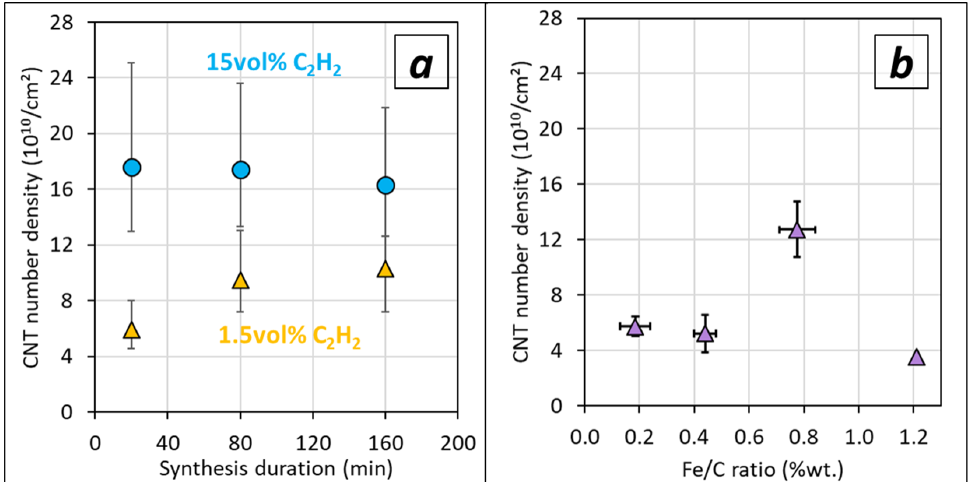
Figure 11. CNT areal number density calculated on samples obtained on HG-Al substrates versus ( a ) synthesis duration for high (15 vol%, blue circle) and low (1.5 vol%, orange triangle) acetylene content, and ( b ) Fe/C ratio for low acetylene content and 80 min synthesis duration. Experimental dots correspond to mean values calculated from mean diameters and lengths, and variation ranges correspond to the standard deviations (±2 σ ).